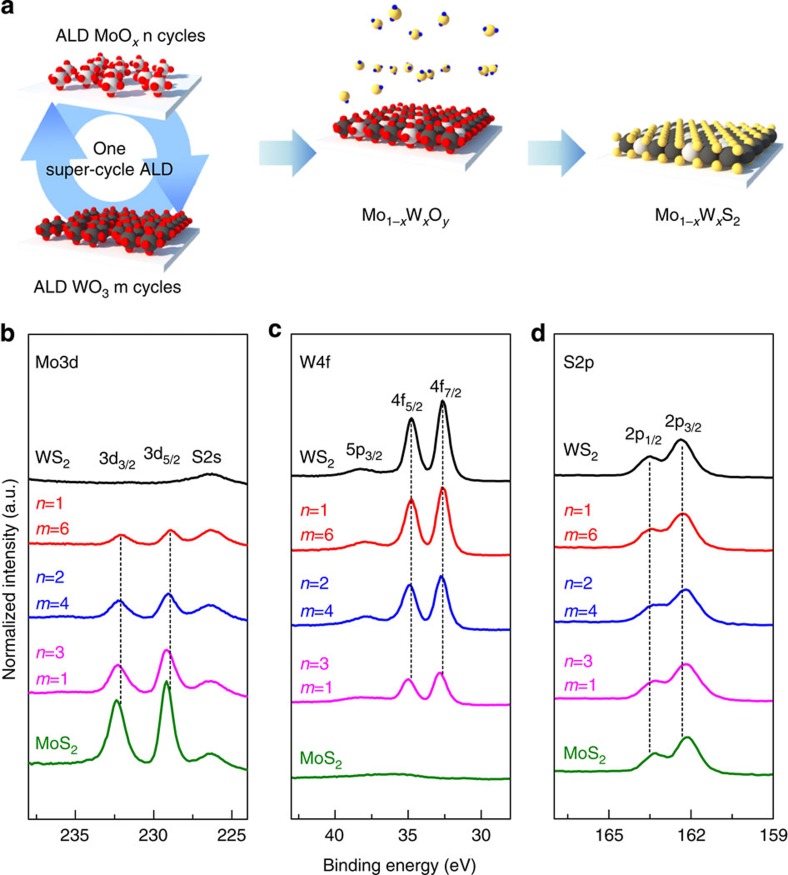
Synthesis and XPS of Mo1−xWxS2 alloy.(a) Synthesis procedure of super-cycle ALD for Mo1−xWxS2 alloy. XPS measurements for (b) Mo3d, (c) W4f and (d) S2p core levels in the 1l Mo1−xWxS2 alloy with different n and m numbers in one super-cycle. All measured XPS results are normalized by S2p3/2 peak intensity.